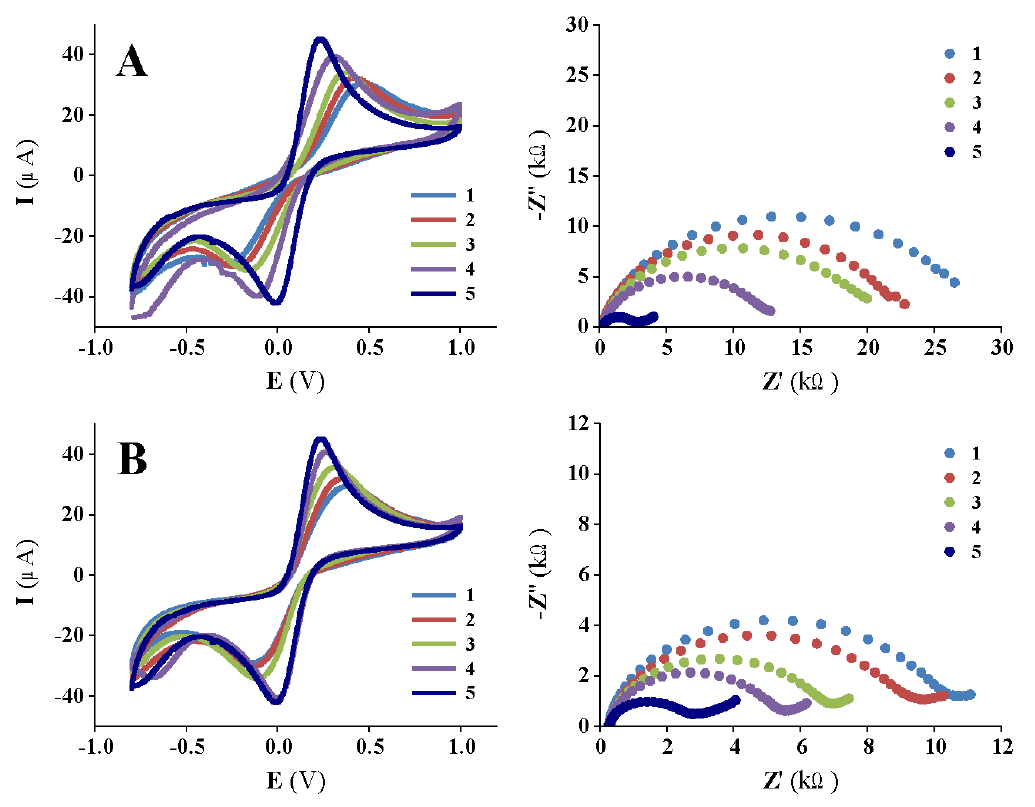
Figure 3. DNA damage detection at the (A) NAF/DNA/SPCE and (B) CHIT/DNA/SPCE. CV and EIS plots of 1 mM [Fe(CN) before (curve 1) and after the incubation of the biosensor in the cleavage agent producing hydroxyl radicals for 2 min (curve 2), 5 min (curve 3), and 15 min (curve 4) followed by the medium exchange. Curves 5 correspond to the bare